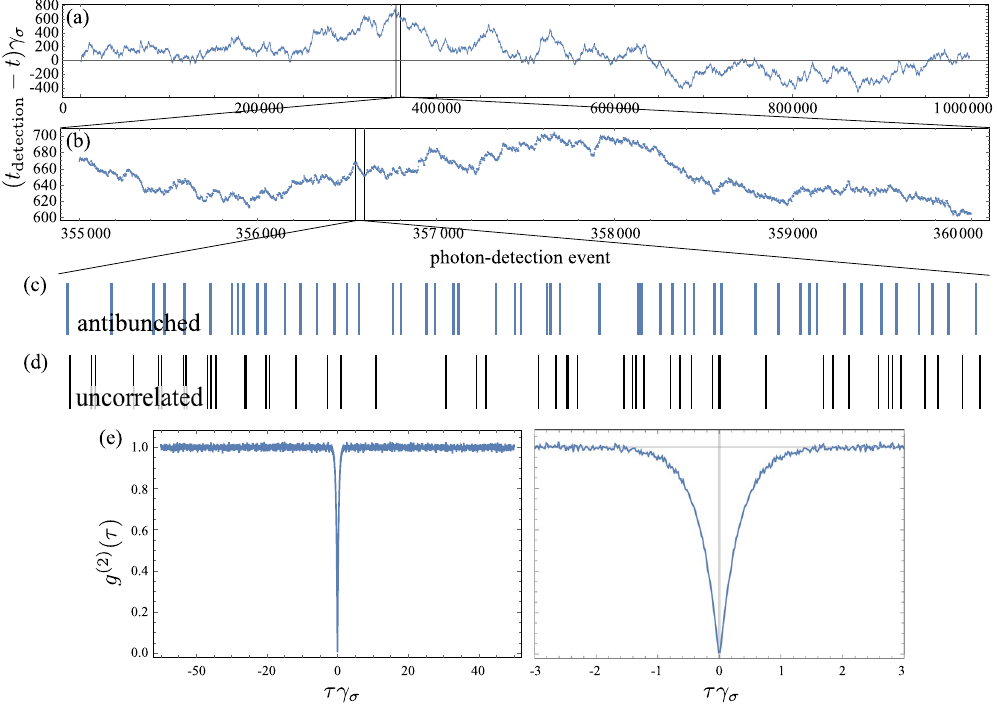
Figure 2. Monte Carlo method on a two-level system. ( a ) Times of emission for 1 000 000 recorded photons as compared to their mean emission rate, exhibiting a classical random walk. ( b ) Zoom of (a) in the highlighted window. ( c ) Zoom of (b) in the highlighted window, with detected photons now displayed in absolute time rather than relatively to their mean emission time. Locally, one can observe a structure in their statistical distribution, with a tendency of ordering and mutual repulsion. This becomes obvious when comparing with uncorrelated photons with the same emission rate, shown in ( d ). The latter exhibit Poisson bursts. ( e ) Intensity correlations g (2) ( τ ) computed from the one million points, in two timescales, featuring a clear antibunching. The inverse lifetime of the two-level system sets the time